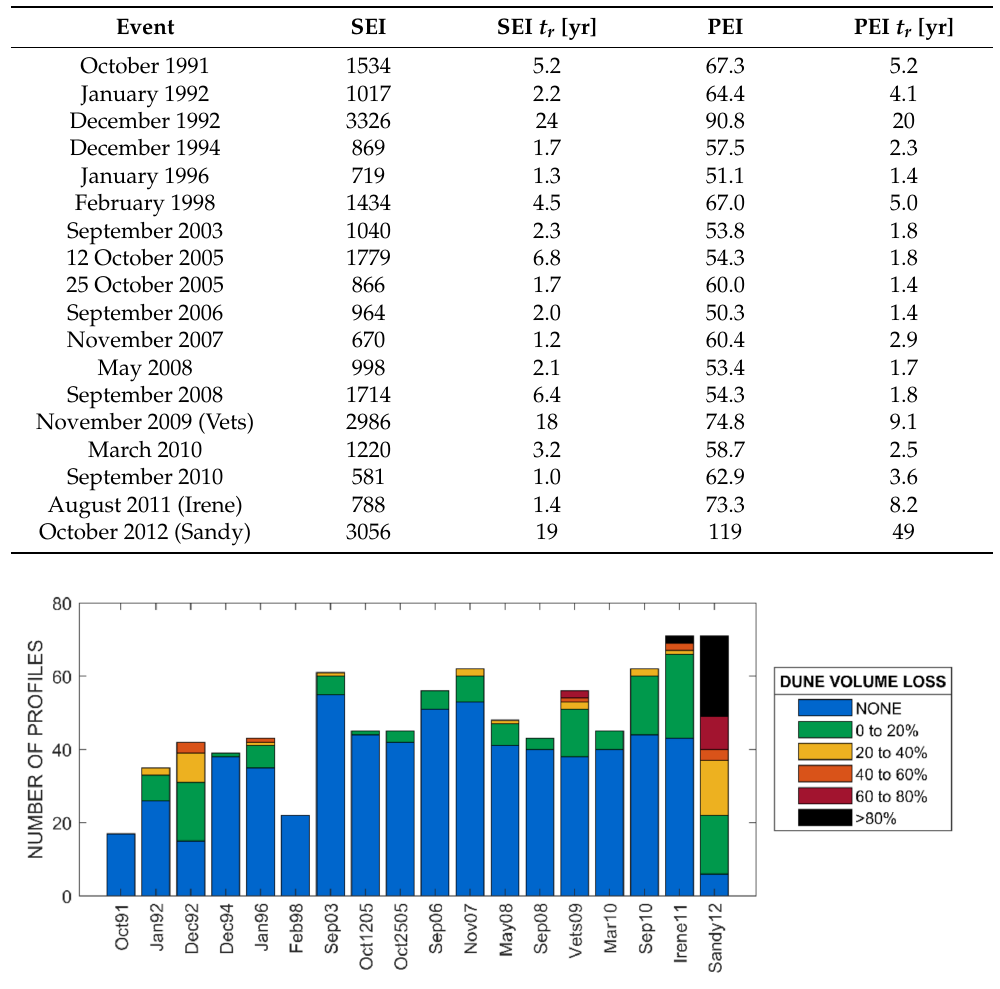
Figure 3. Aggregated summary of quantity of profiles available and corresponding dune volume loss percentage by storm for the New Jersey coast. Courtesy of [20]. Table 3. Storm Categories based on SEI and PEI including parameter value, return period (Tr) and annual probability of exceedance. Storm categories determined by [38], return period calculated from